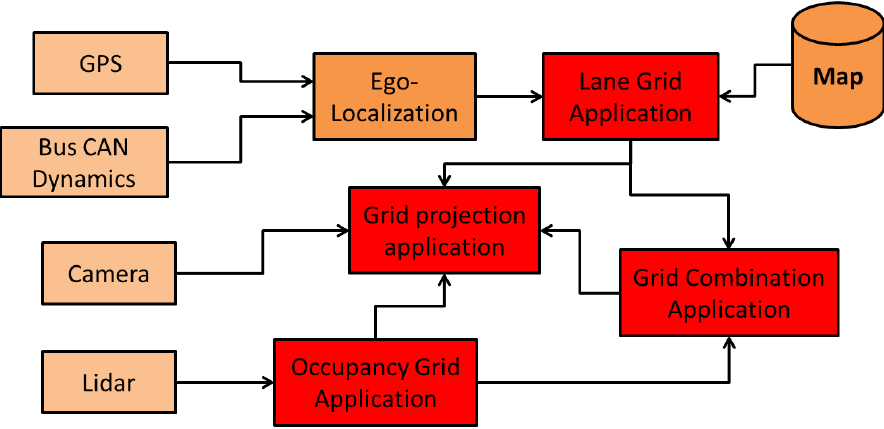
Figure 10. Software implementation in